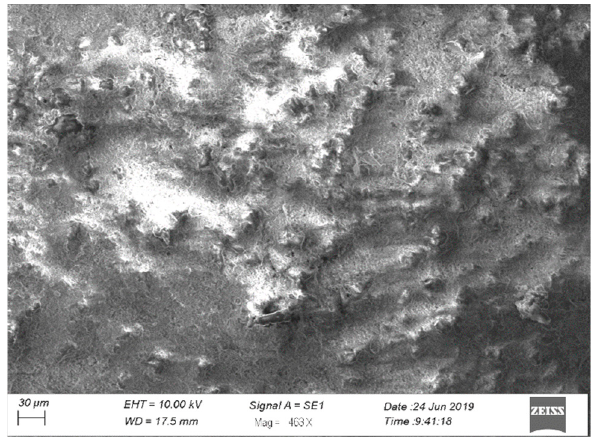
Figure 4. SEM image of the coating surface prior to testing.